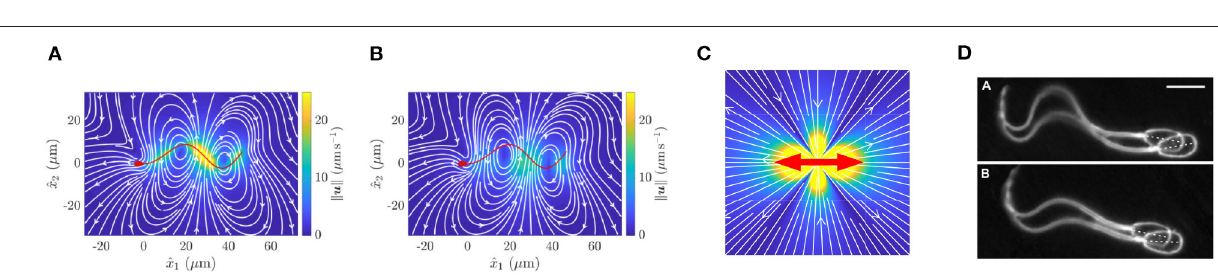
Dresdner et al., 1980). Especially when coupled with the